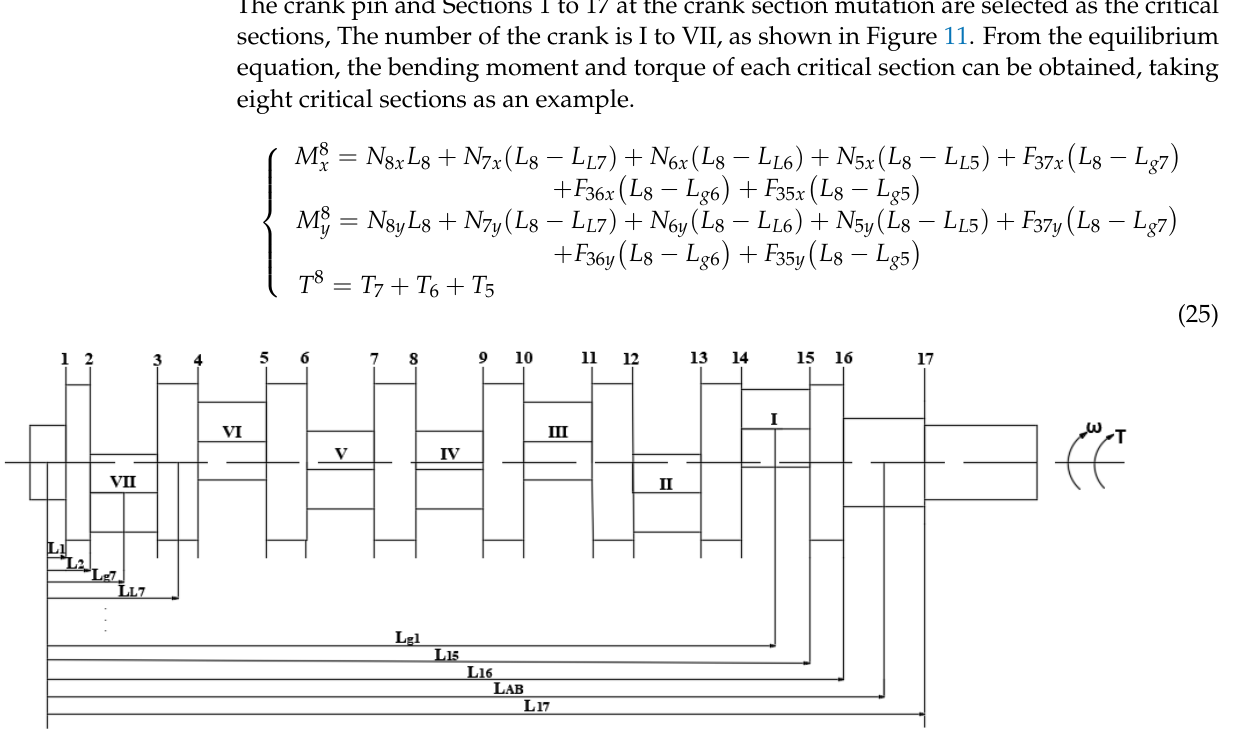
Figure 11. Crankshaft critical sections.